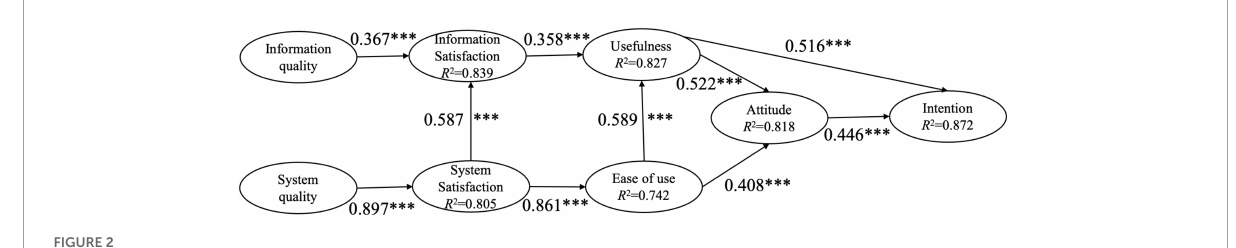
FIGURE2 Structural model for the group of online learning. ∗∗∗ p < 0.001.